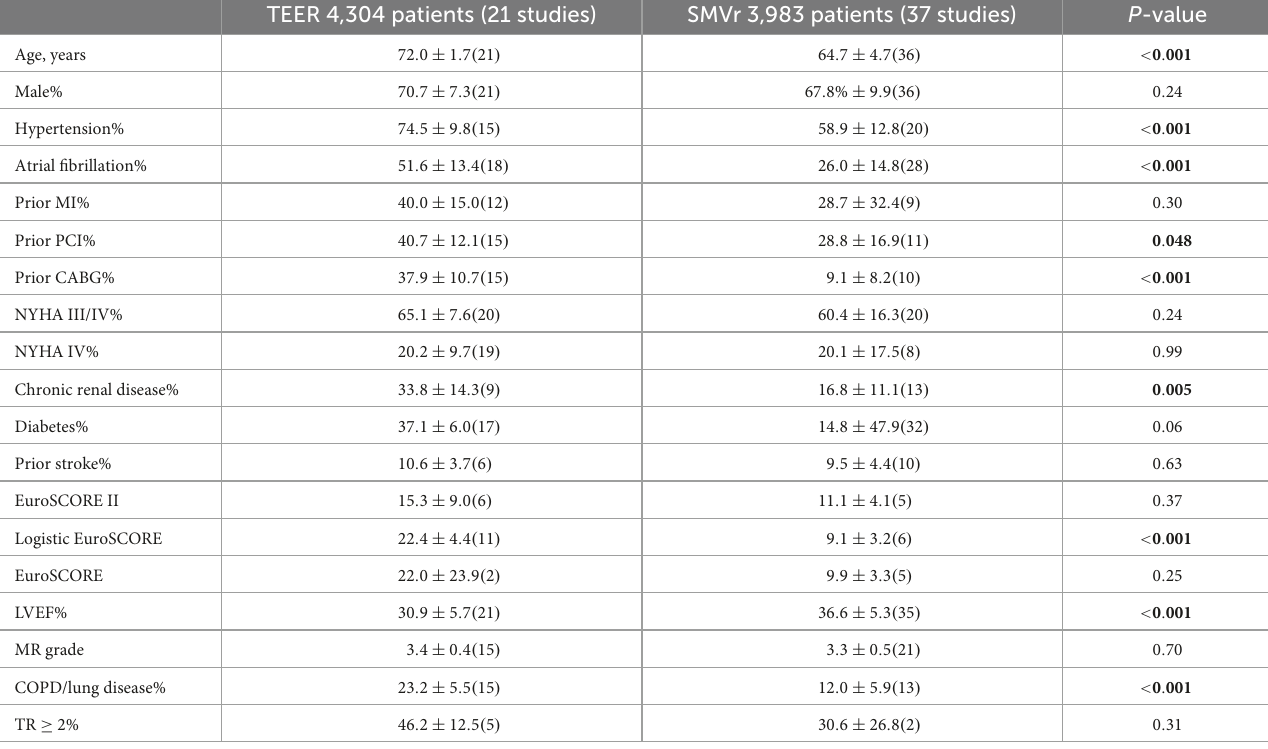
TABLE 1 Baseline characteristics of patients in the TEER and SMVr